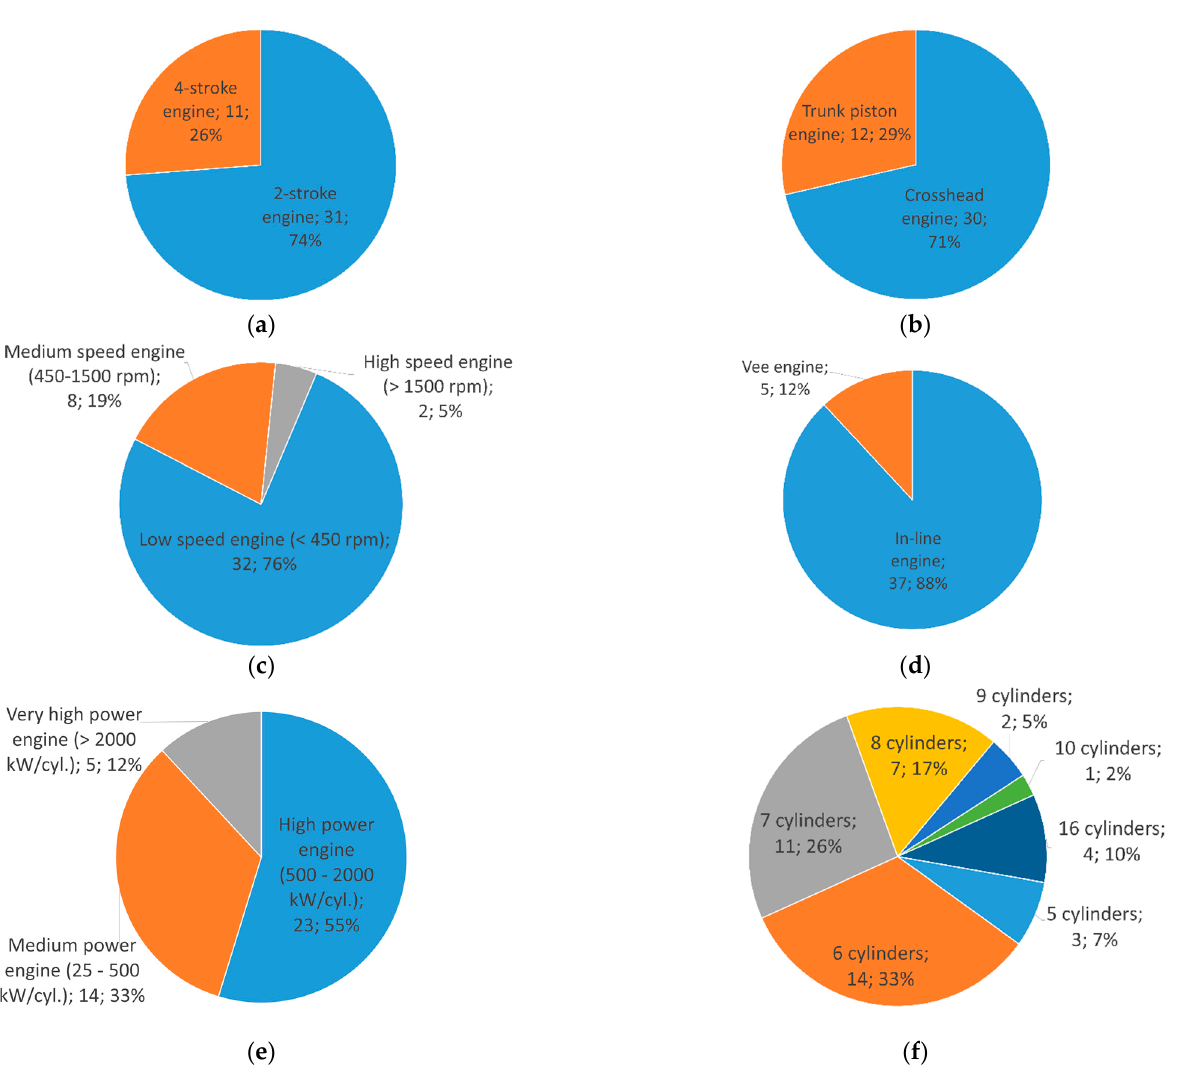
Figure 12. Number of main engine turbocharger explosions as a function of the engine type: ( a ) number of strokes; ( b ) crank-slider mechanism type; ( c ) engine speed; ( d ) cylinder layout; ( e ) engine power; ( f ) number of cylinders.